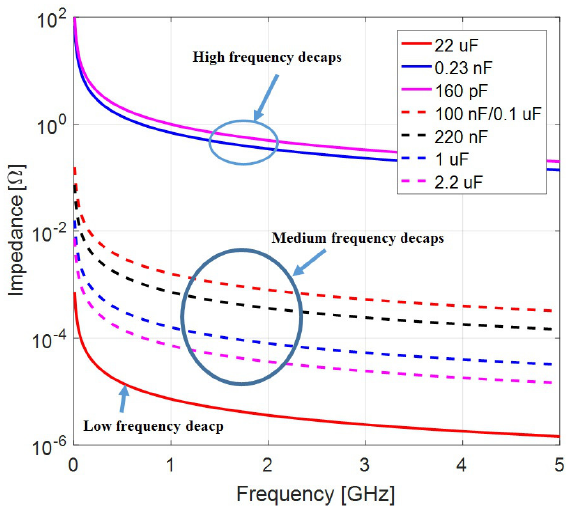
Figure 18. Comparison of impedance results of already installed (100 nF , 220 nF , 1 µ F and 2.2 µ F ) ideal decaps and the changed decaps (0.23 nF , 160 pF , and 22 µ F ) for DOE